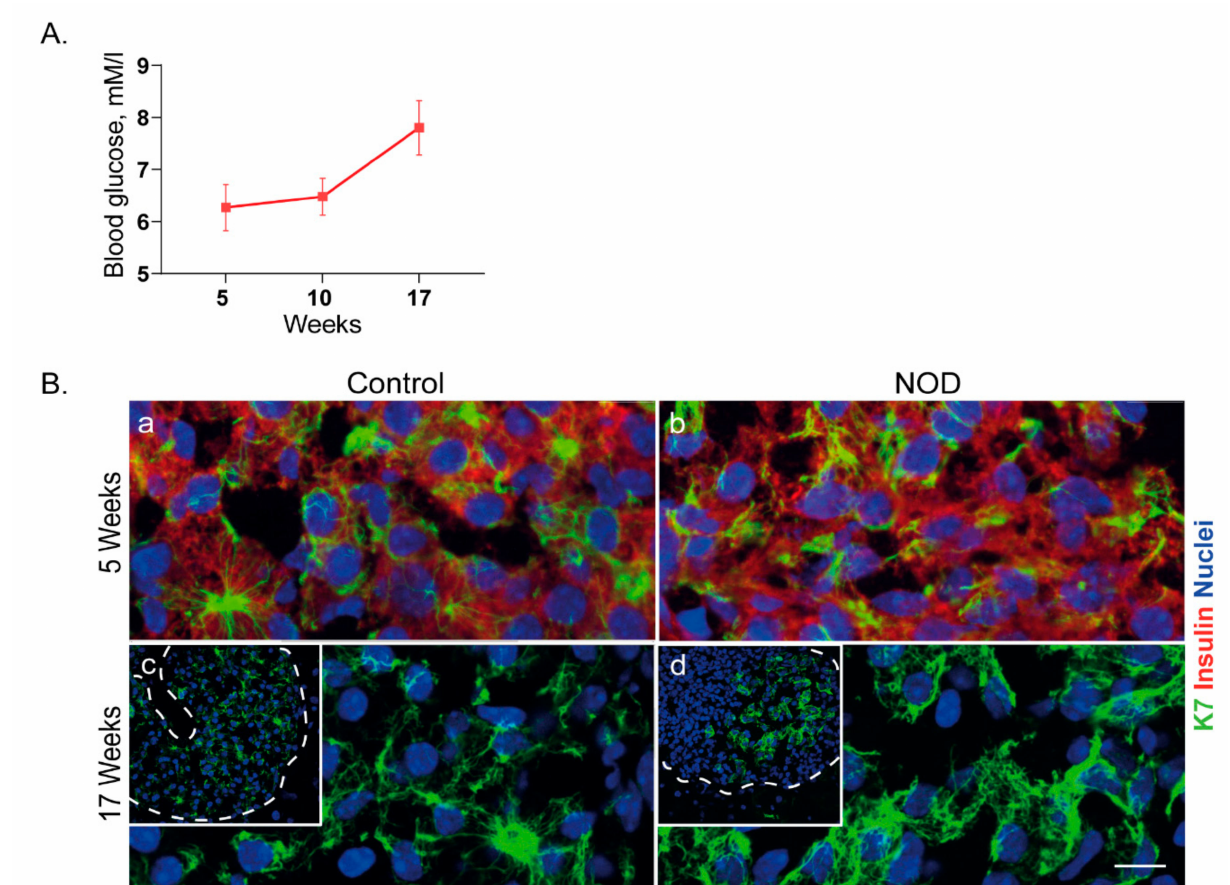
Figure 5. K7 is upregulated in pancreatic islets of prediabetic NOD mice. ( A ) Non-fasting blood glucose levels as a function of time, are shown for NOD mice during 17 weeks follow-up; mean ± SEM. ( B ) Pancreatic tissue sections from control (K8 +/+ ) and NOD mice in 5 weeks ( a , b ) and 17 weeks ( c , d ) of age, were immunostained for K7 (green), insulin (red) and nuclei (blue). The inserts in c and d show lower magnifications of islets (outlined by dotted lines), and the main images in c and d are higher magnification of a section of the shown islets. K7 expression is similar to control in young NOD 5-week old mice, whereas in prediabetic 17-week old mice, K7 is upregulated in some islets. Scale bar = 20 µ m. n = 2 mice per